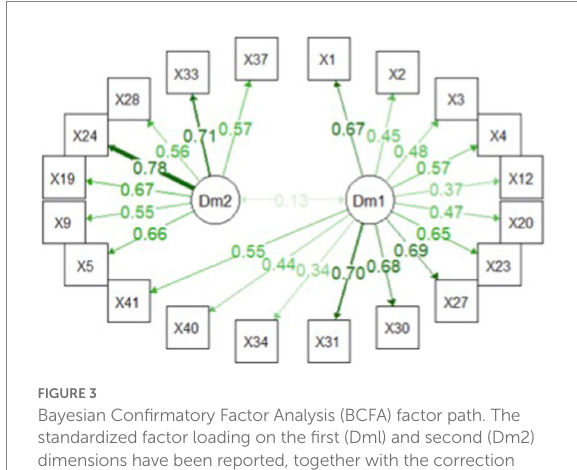
FIGURE 3 Bayesian Confirmatory Factor Analysis (BCFA) factor path. The standardized factor loading on the first (Dml) and second (Dm2) dimensions have been reported, together with the correction among latent factor 0.13 [95% CI = − 0.079 to